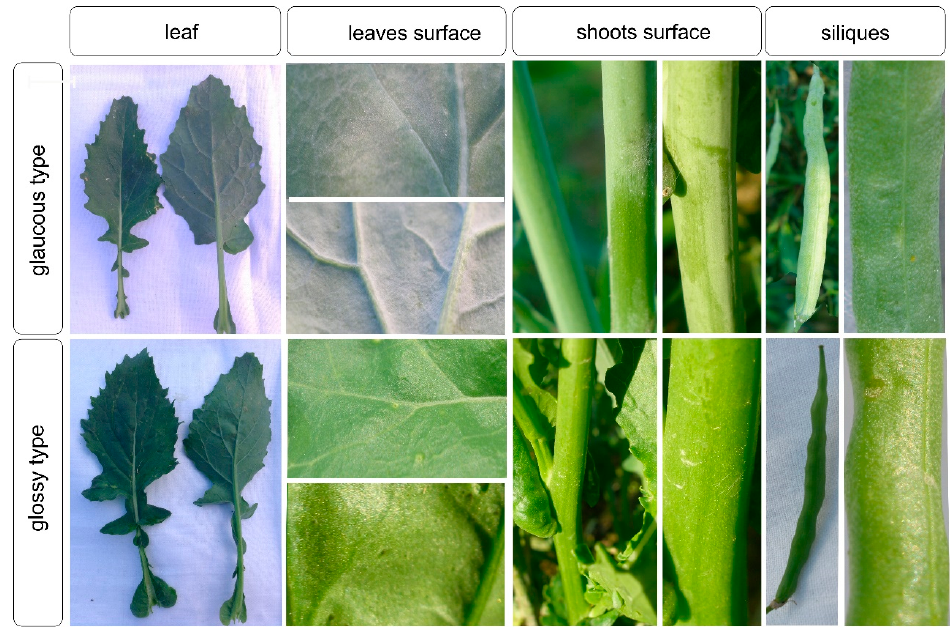
Figure 1. Morphological features of the leaf surface, fragments of the abaxial and adaxial leaf surfaces, the surface of stems and siliques of mutant forms (M 6 ) of spring rapeseed differing in the presence / absence of bloom. Gloss and the absence of a bloom on the surface of leaves, shoots, and siliques in glossy plants are clearly visible.